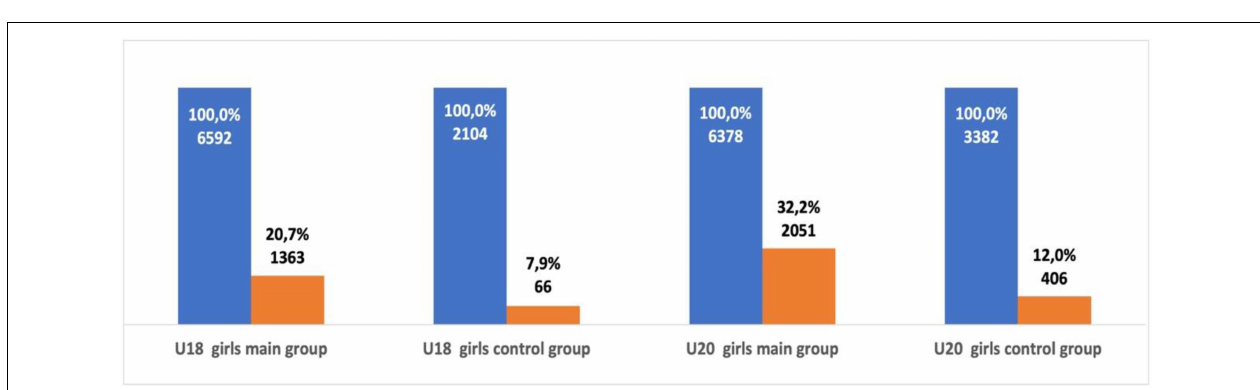
FIGURE 5 | The number of successful U18 and U20 male athletes as a senior in group one and group two.